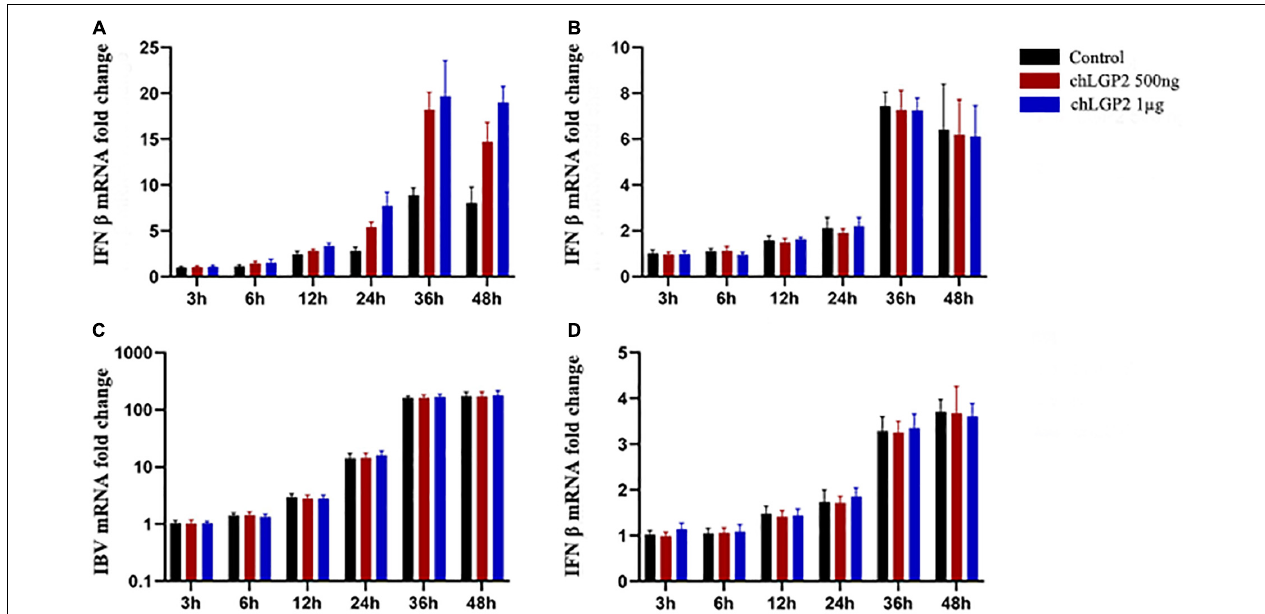
FIGURE 2 | The cell and virus-specific effect of chLGP2. Post-IBV Beaudette infection, chLGP2 overexpression significantly upregulated IFN- β expression in (A) HD11 cells but not in (B) DF-1 cells. (C) chLGP2 overexpression did not inhibit the replication of IBV M41 in DF-1 cells. (D) chLGP2 did not affect the IFN- β expression during IBV Beaudette infection in DF-1 cells. Data are the mean values of three independent experiments, and error bars denote mean ± SDM.